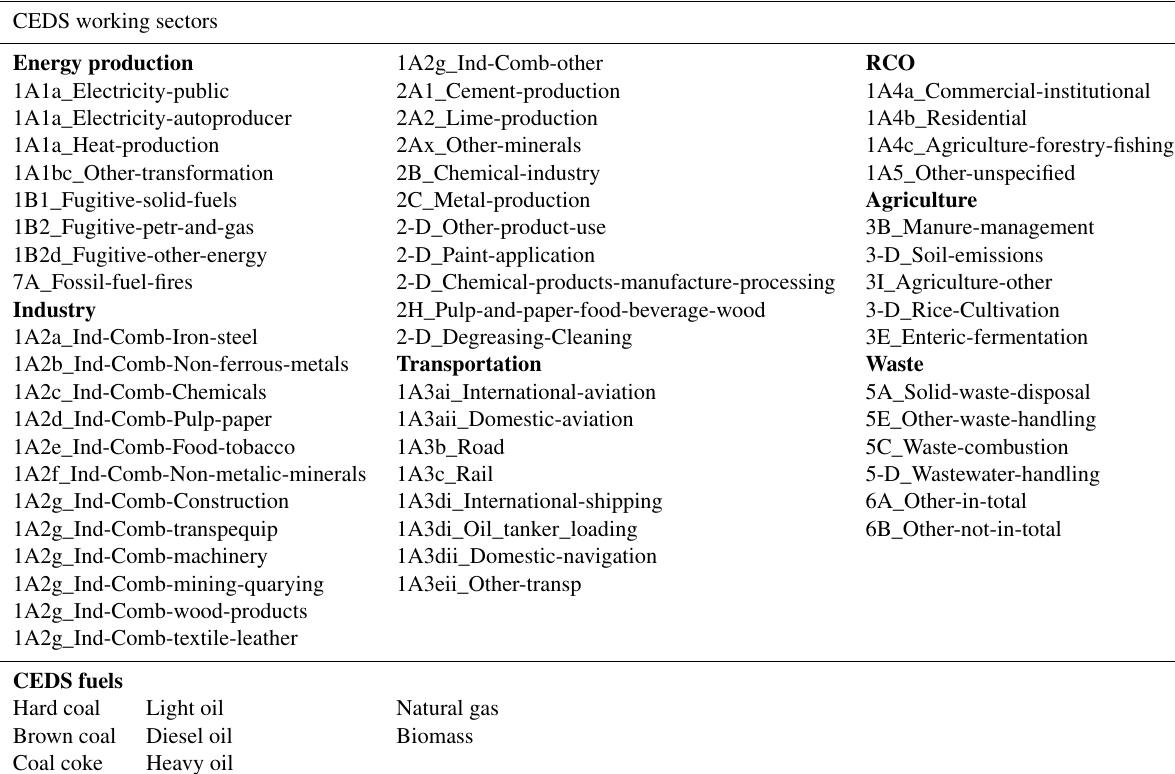
Table 1. CEDS working sectors and fuels (CEDS v2016-07-26). RCO indicates the “residential, commercial, other” sector. CEDS working